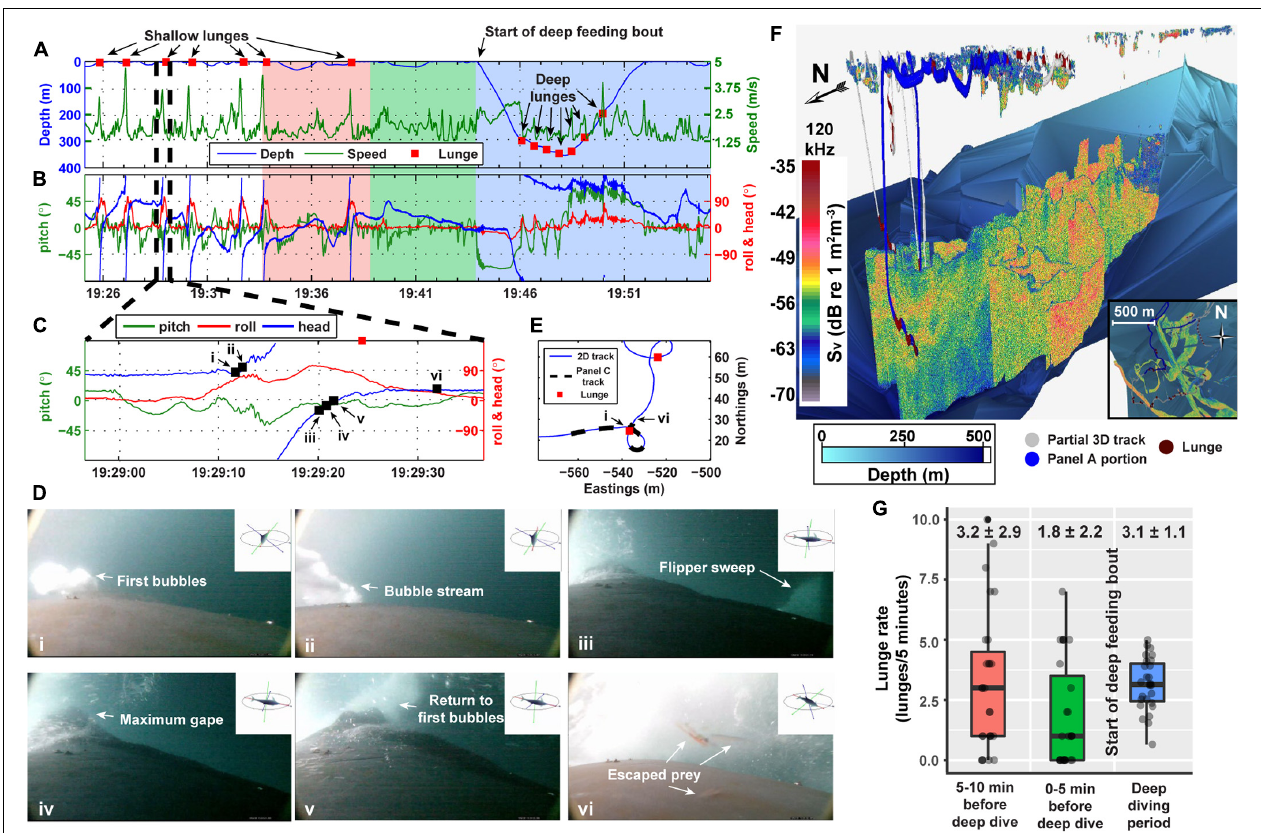
FIGURE 3 | Transition from shallow to deep feeding. (A) Time series of depth and speed with locations of lunges marked. Background colors match the time periods of summary data in panel (G) . (B) Time series of pitch, roll, and heading. All surface feeding events displayed are bubble-nets with 360 ◦ circles preceding the lunge. (C) Zoomed in version of pitch, roll and heading traces for a single bubble-net feeding event. (D) Video images from the tag corresponding to the time points marked in panel (C) . (E) 2D track of two bubble nets, including the subsection plotted in panel (C) . (F) 3D track spatially located with mapped prey data showing the transition from surface to deep feeding. Inset is overhead view for context (note that bathymetry color is not to scale in the inset). (G) Average number of lunges across all deployments preceding the onset of deep foraging, and the feeding rate during the first deep feeding events (feeding rate from the start of a dive until the start of the next dive). Box plots are median and inter-quartile range, numbers are lunges per 5 min (mean ±